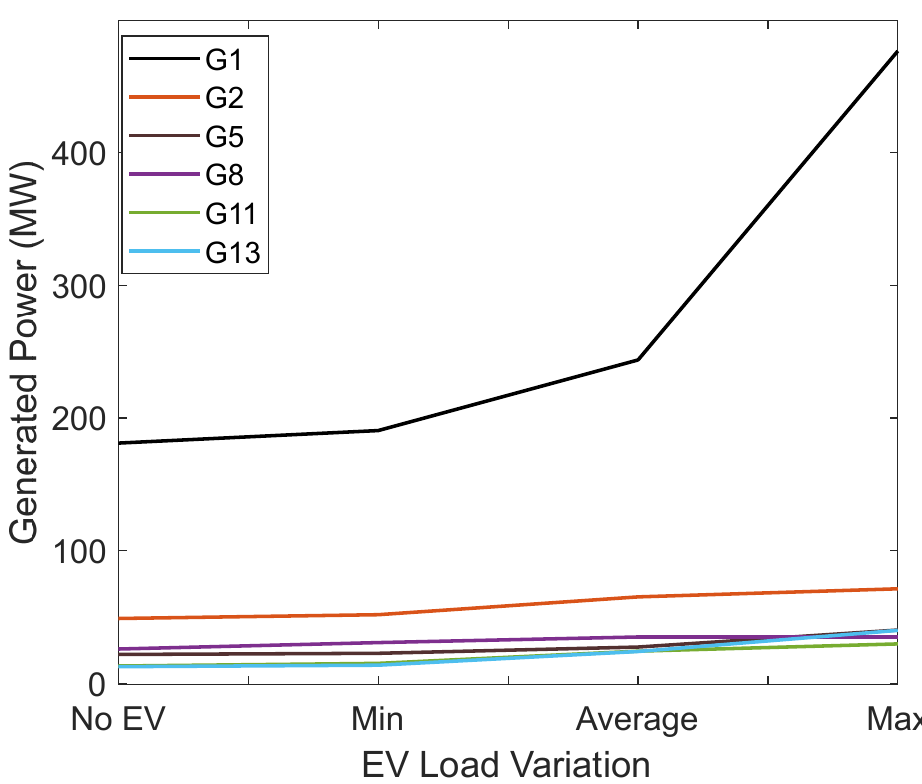
Figure 15. The variation of the generated power from the conventional generators connected to the IEEE 30 bus systems without the use of DR and V2G.